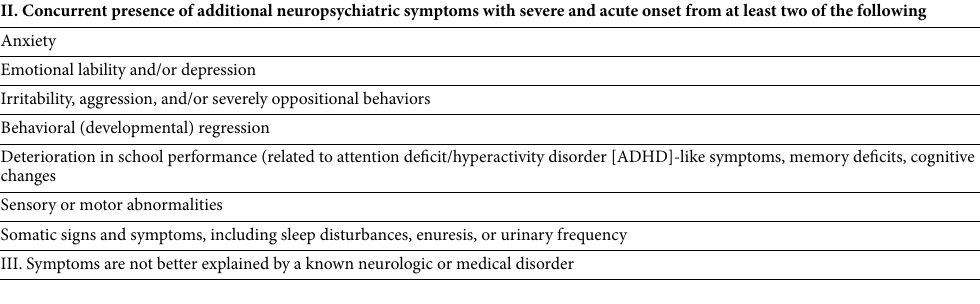
Table 1. Diagnostic criteria for PANS adapted from Cheng et al. 1